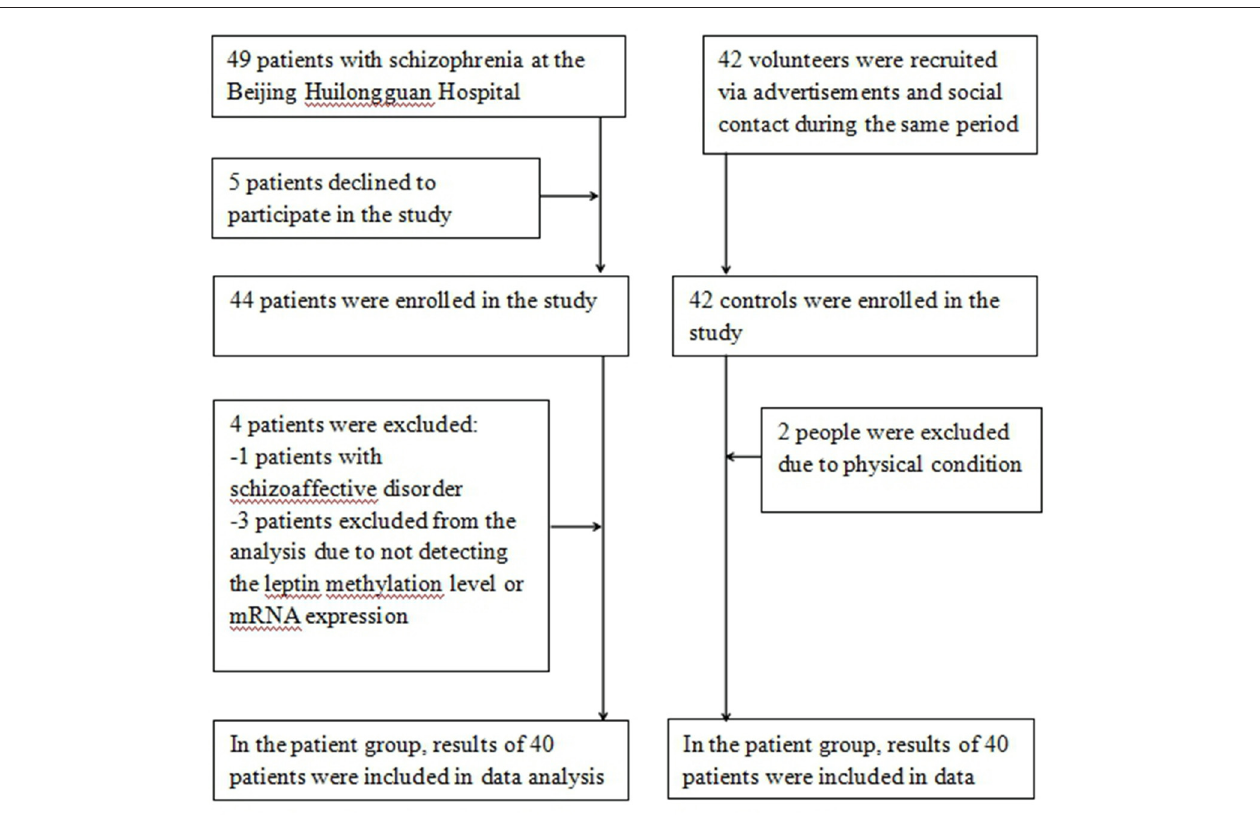
FIGURE 1 | Overview of the flow of participants through the